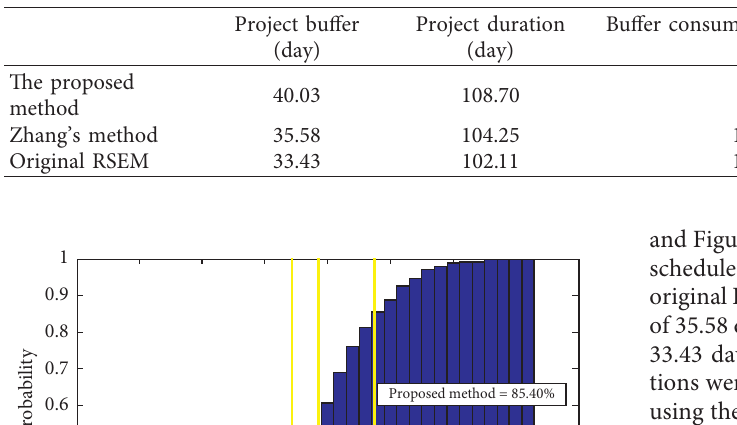
Table 4: Case project results.